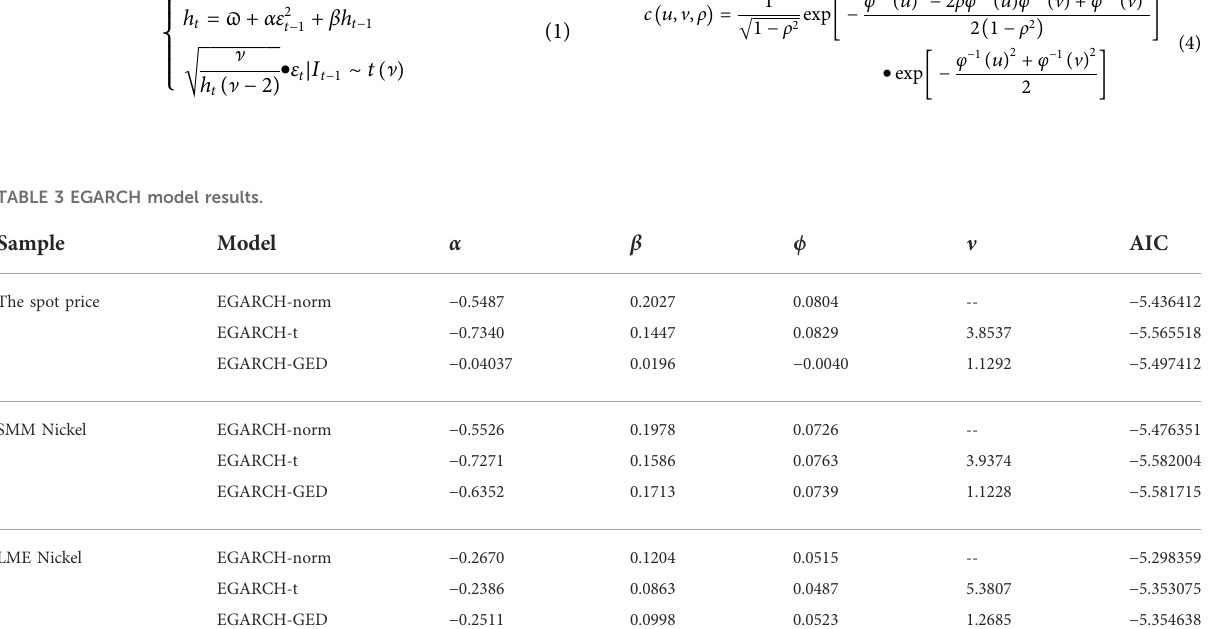
TABLE 3 EGARCH model